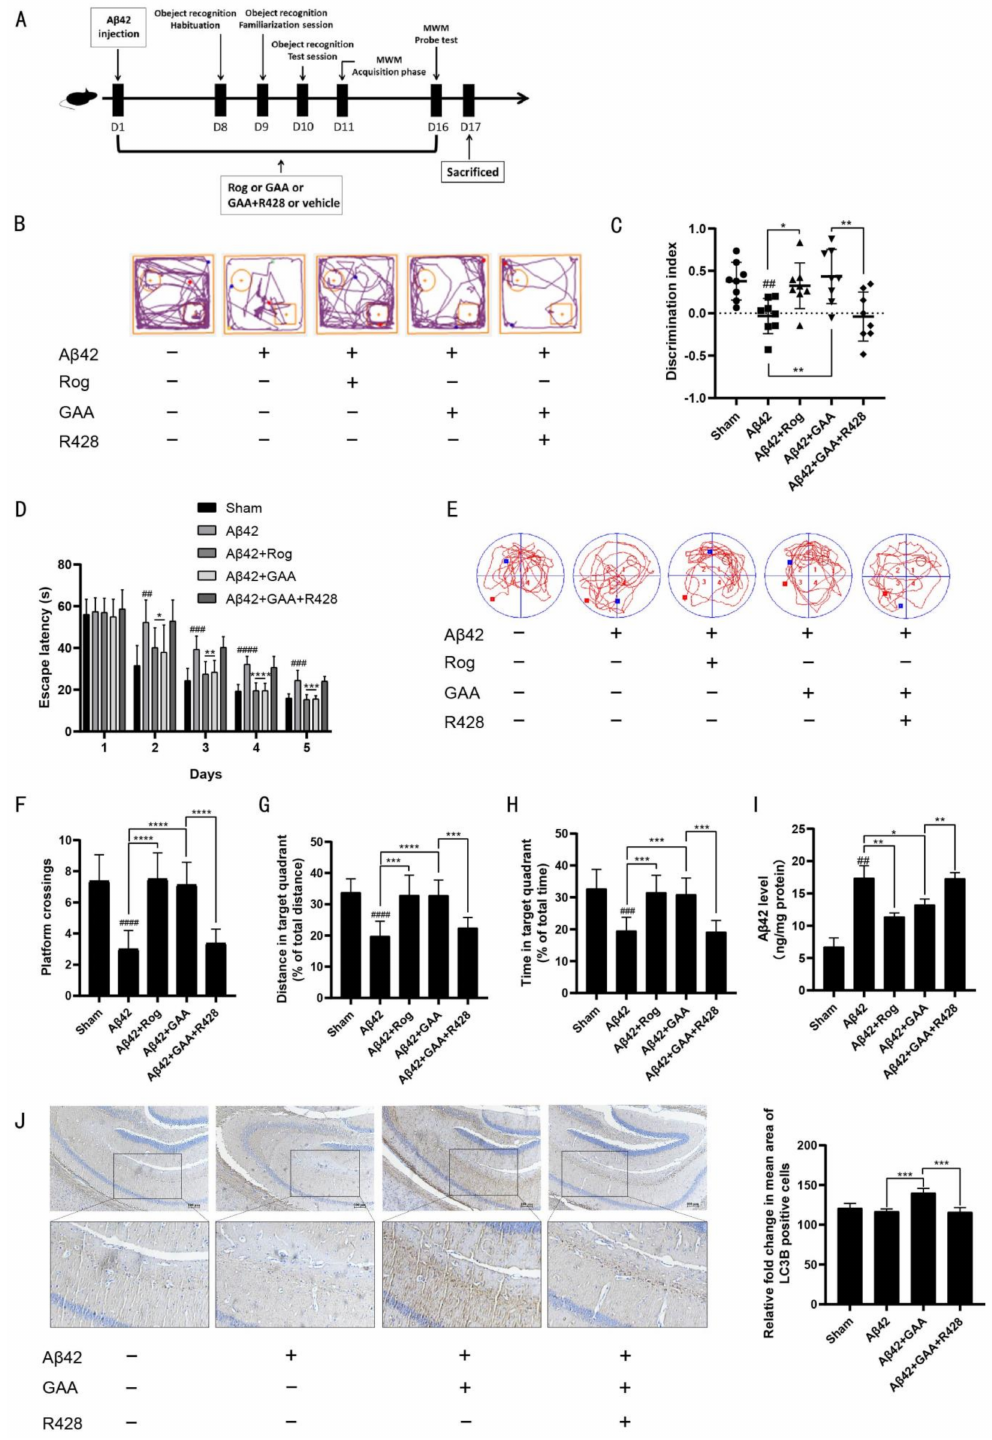
Figure 4. GAA ameliorates A β 42-induced behavioral deficits in A β -injected mice through Axl. ( A ) Experimental design for the animal study. Cerebroventricular injection of aggregated A β 42 (82 pmol/ µ L, 5 µ L/mouse) was applied to 8-week-old mice. ( B ) Representative motion track and ( C ) the discrimination index in the object recognition test. A β 42 vs. Sham: p =